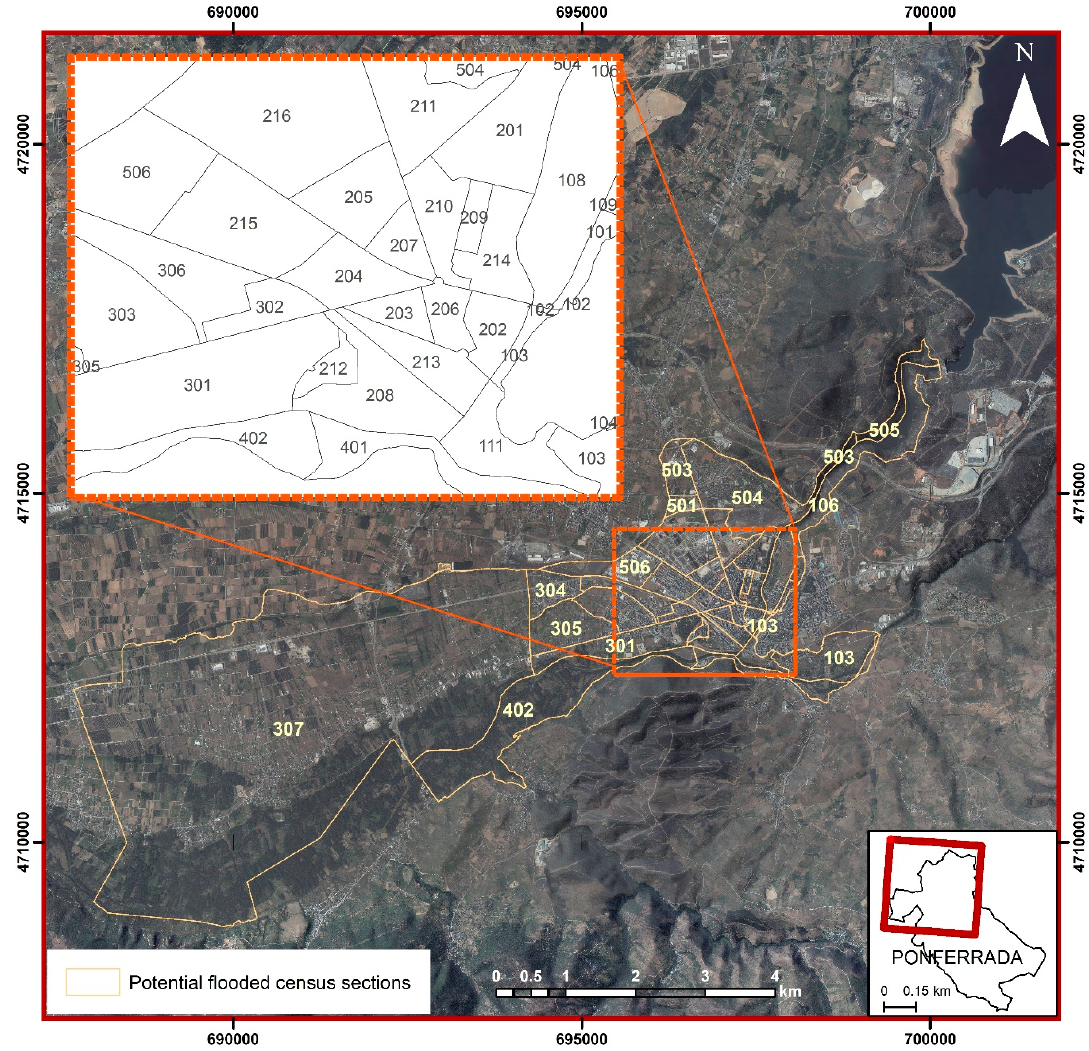
Figure 2. Census sections potentially affected by the water sheet.